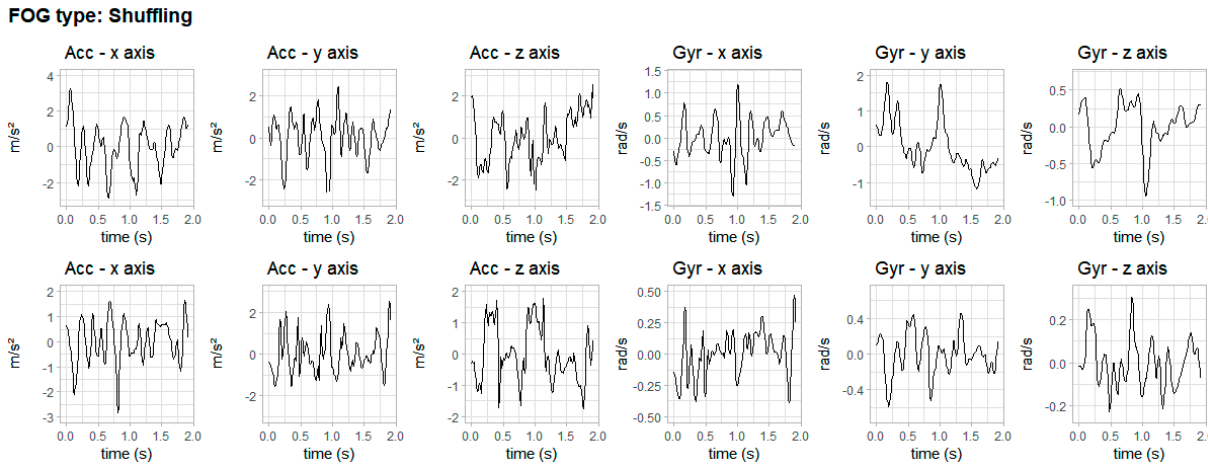
Figure 7. Typical waveforms of inertial signals during festination. Row 1 shows festination in one volunteer and row 2 shows festination in another volunteer.